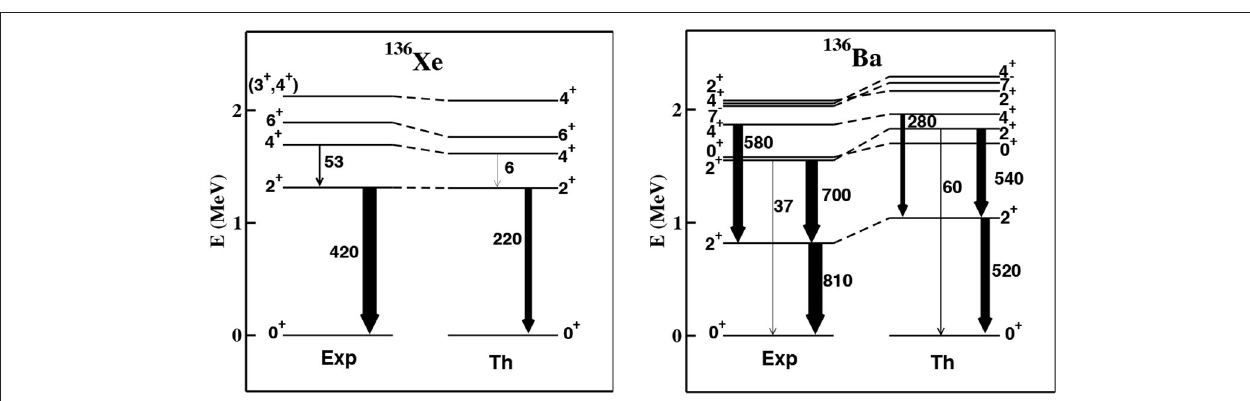
FIGURE 13 | Same as Figure 12 but for 136 Xe and 136 Ba. Reproduced from reference